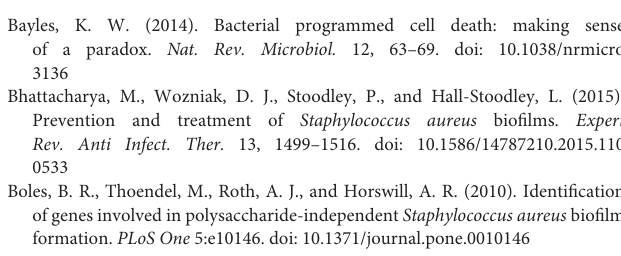
FIGURE S1 | Fluorescent staining and enzymatic digestion to reveal S. aureus biofilm matrix components: proteins, eDNA and polysaccharides. S. aureus biofilm formation (24 h) was stained with specific fluorochromes: Sypro Ruby (red) for staining proteins, Concanavalin A (blue) for staining α -mannopyranosyl and α -glucopyranosyl residues and Syto9 (green) for live bacteria staining. Fluorescence microscopy with live (green color), Sypro Ruby (red color, merged color with Syto9 is yellow) (A) and Concanavalin A (blue color) (B) , scale bar = 20 µ m. Biofilm (24 h) representation after a 3D reconstruction by Imaris software after acquisition in confocal microscopy with SYPRO Ruby and Syto9 staining, scale bar = 10 µ m (C) . Extracellular matrix formation was also detected by enzymatic digestion of proteins by proteinase K and DNA by DNAse I (D) . FIGURE S2 | Crystal violet staining pictures of S. aureus biofilm formation on plastic surfaces. Ctrl, control (no bacteria); MM, Minimal Medium; no glu, MM without glucose; no CAA, MM without casaminoacids; Mg × 20, MM containing × 20 serological concentration of magnesium (=1 mM). FIGURE S3 | Diluted cell medium increased S. aureus biofilm formation. (A) Planktonic growth normalized to control (B) biofilm biomass quantified by crystal violet staining and (C) fold-increase of adhesion in the live adhered cells model. n = 9. FIGURE S4 | Fluorescence microscopy confirmed the impact of osteoblast culture supernatants on S. aureus biofilm formation. Fluorescence microscopy with live (green color)/dead (red color) staining. Control medium, 50% DMEM + 10% FCS plus 50% of minimal media; SN 50, culture with 50% of osteoblast culture supernatants plus 50% of minimal media; Control media + TNF- α , 50% DMEM, 10% FCS, 20 ng/ml TNF- α , 50% minimal media; SN 50 + TNF- α , culture with 50% of osteoblast culture supernatants exposed to 20 ng/ml of TNF- α plus 50% of minimal